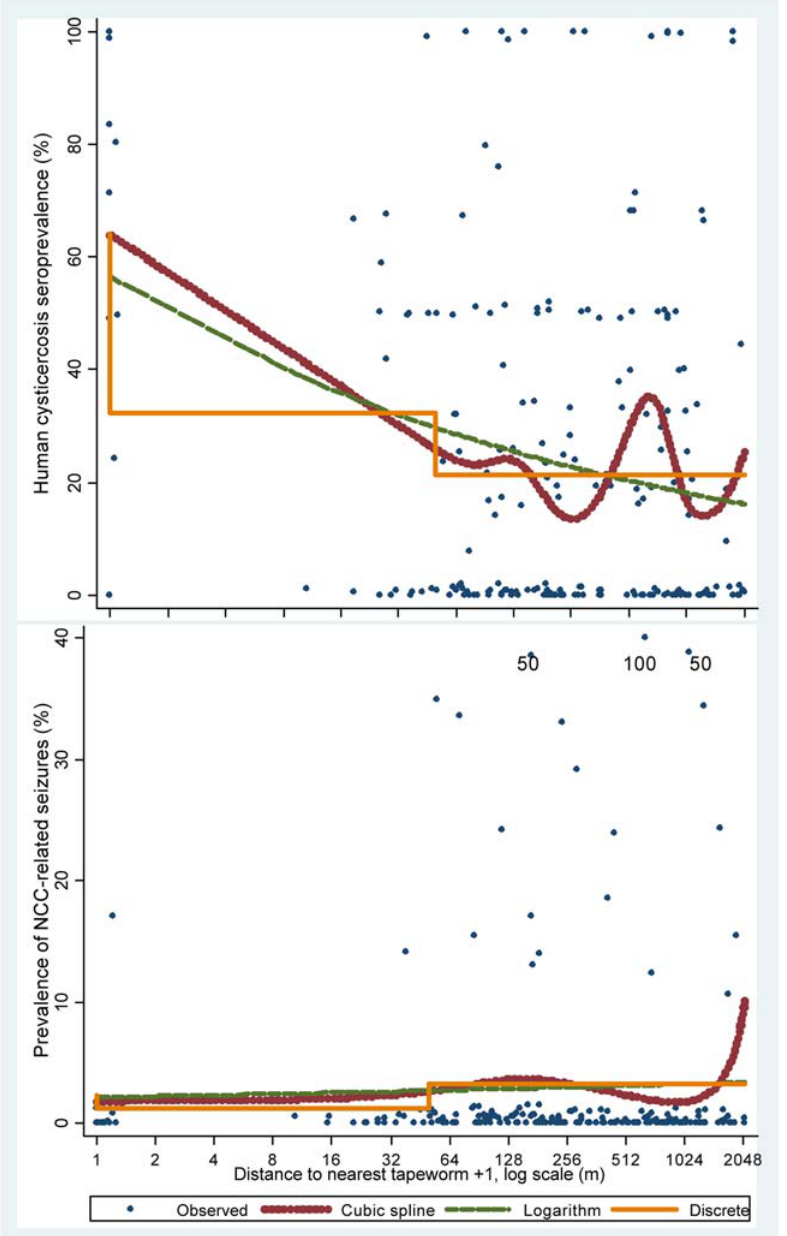
Figure 2. Household-level prevalence of human cysticercosis seroprevalence and NCC-related seizure by distance to the nearest T. solium tapeworm carrier, Tumbes, Peru, 1999. Observed prevalence rates in both figures are slightly jittered, and seizure frequencies 50% and 100% are represented as 40%.